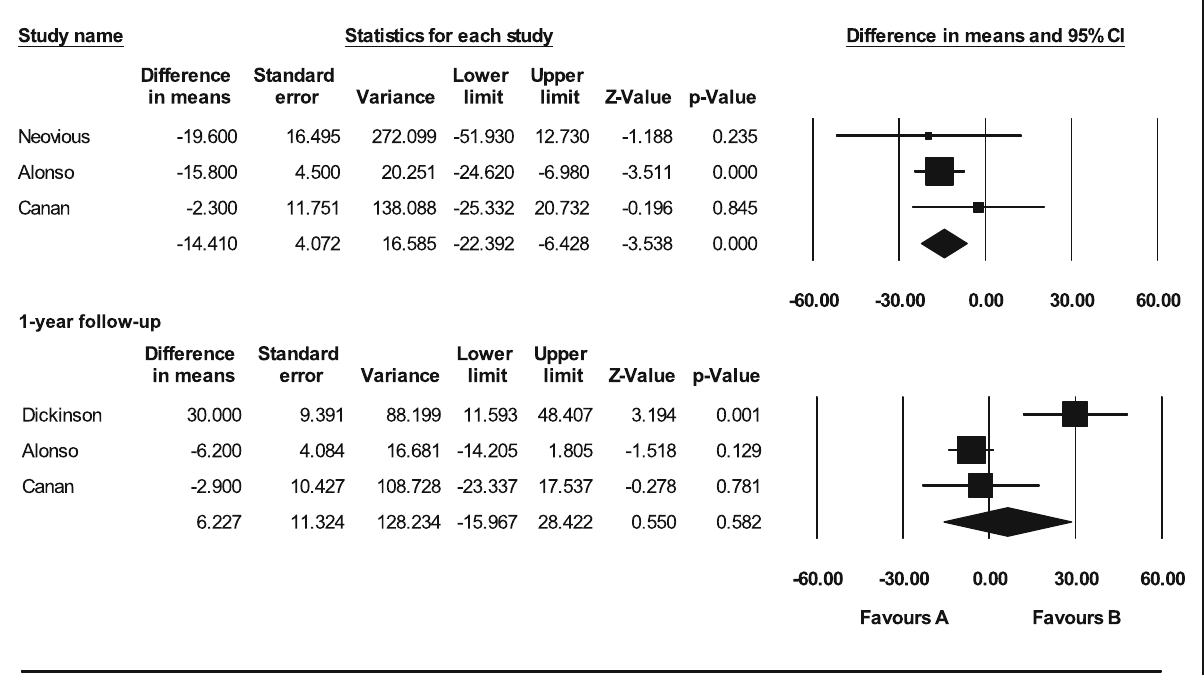
Fig. 3 Comparison of radiographic assessment between autologous bone and rh-BMP2 graft: bone graft volume after 6-month and 1-year follow-up [favors A: autologous bone graft; favors B: alloplastic bone graft]